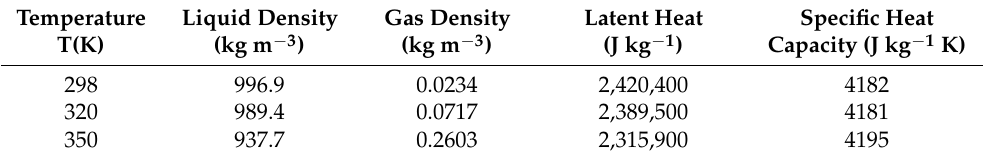
Table 5. Relevant parameters of liquid water in a saturated